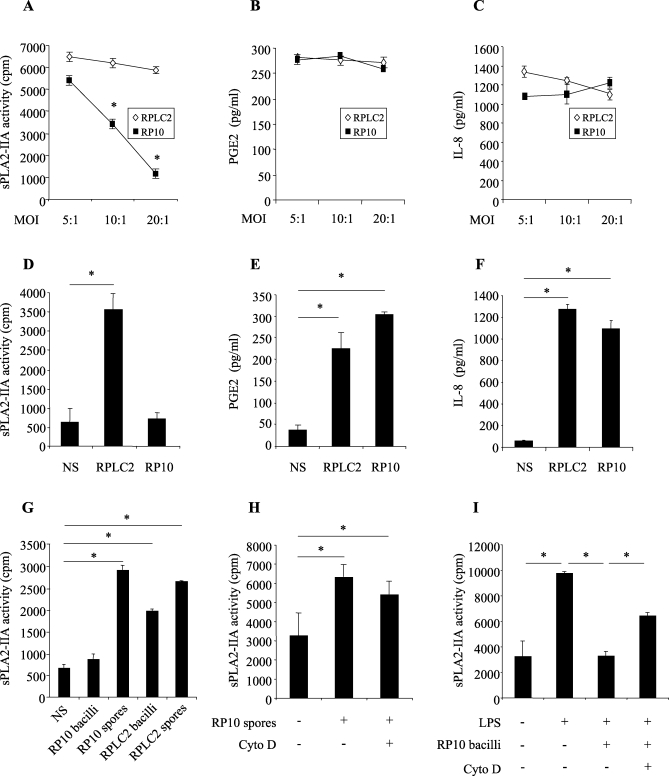
Infection of AMs with B. anthracis Inhibits sPLA2-IIA Secretion, but Not IL-8 or PGE2 Release(A–C) AMs were infected with B. anthracis (RP10 and RPLC2 strains) at the indicated MOI for 3 h in the absence of antibiotics. Cells were then washed and incubated overnight in RPMI 1640 supplemented with 3% FCS and antibiotics, in the presence or absence of LPS (50 ng/ml). Supernatants were collected, and sPLA2-IIA secretion and PGE2 and IL-8 concentrations were measured. Effects of bacilli on sPLA2-IIA secretion (A) and PGE2 (B) and IL-8 (C) production in LPS-stimulated AMs.(D and E) Effect of bacilli (MOI 20:1) on sPLA2-IIA secretion (D), and PGE2 (E) and IL-8 (F) production in unstimulated AMs. NS, not stimulated.(G) Effect of spores and bacilli (MOI 20:1) on sPLA2-IIA secretion (G) in unstimulated AMs.(H and I) Effect of Cyto D on the modulation of sPLA2-IIA expression by RP10 spores (H) and bacilli (I). AMs were incubated with 3 μM Cyto D for 30 min before addition of bacteria (MOI 20:1). AMs were washed 3 h later and incubated in the presence (I) or absence (H) of LPS.The data are the mean ± SEM and are representative of four separate experiments. An asterisk (*) indicates p < 0.05.